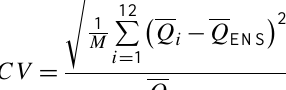
Fig. 2b. Percentage deviation of annual mean modeled discharge (PCR-GLOBWB, ERA6190 run) from 1) observed annual mean discharge (deviation from GRDC) and 2) the sum of observed annual mean discharge and estimated water use as an approximation of natural flow (Deviation from GRDC + estimated water use).